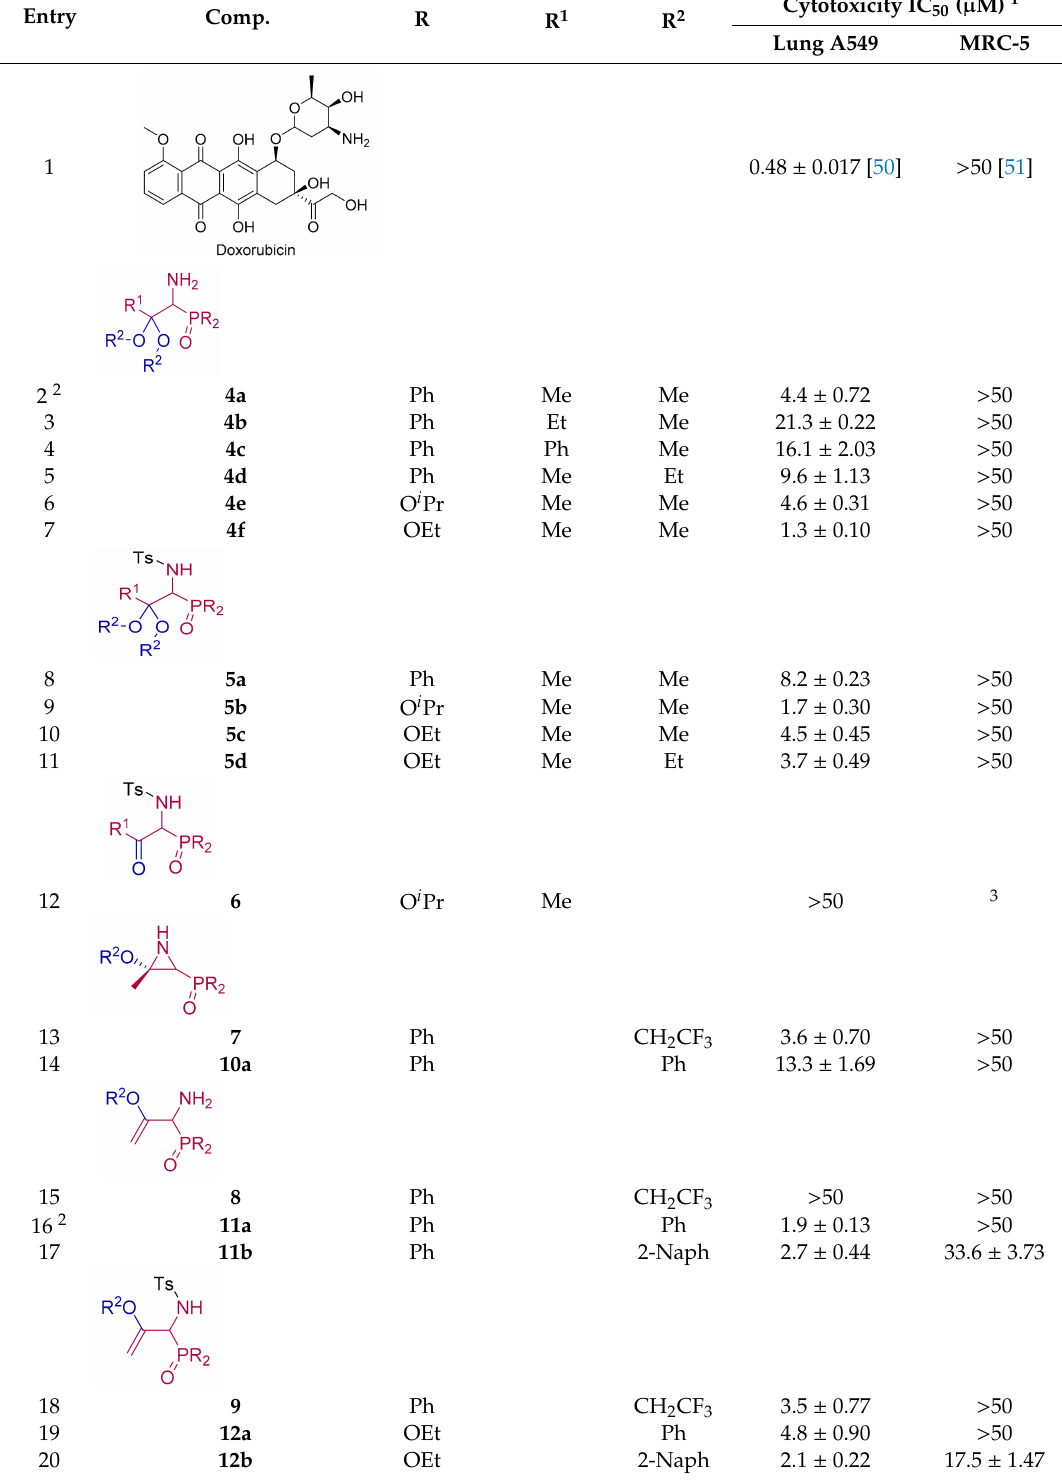
Table 4. Antiproliferative activity of synthesized compounds obtained from the addition of alcohols and phenols to 2 H -azirines 1